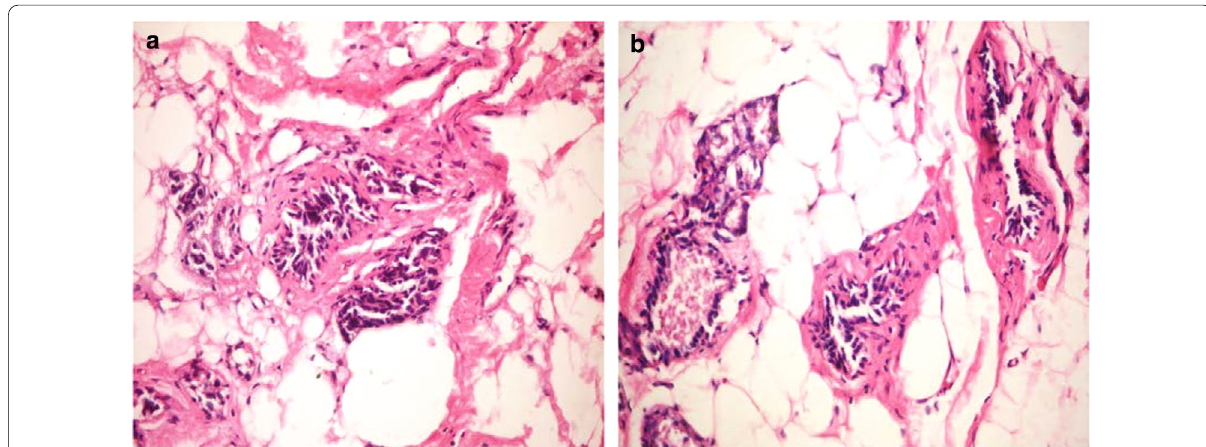
Fig. 1 a , b Rat mammary gland with adenocarcinoma. Notice proliferating anaplastic cells arranged in acini without basement membrane (H&E 400). [Control (injected animals)] ×